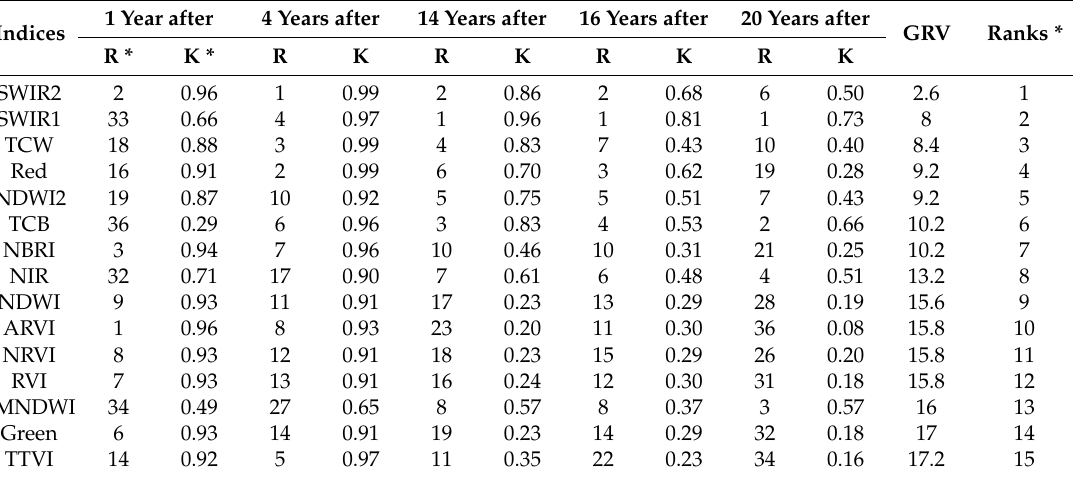
Table 3. The classification accuracy by the RF classifier ( ntree = 1000; mtry = 1) of each predictor against the validating samples of all observed